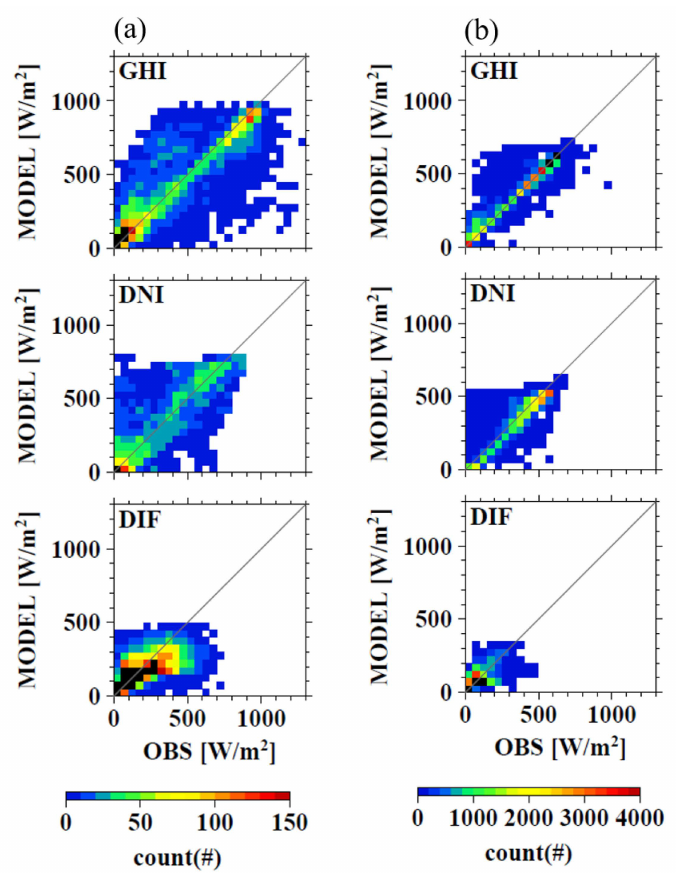
Figure 5. Hexbin plots of GHI (top), DNI (middle), and DIF (bottom) for dx500m in ( a ) the Exp-Summer of 2015 and ( b ) the Exp-Winter of 2016 at Tsukuba station.